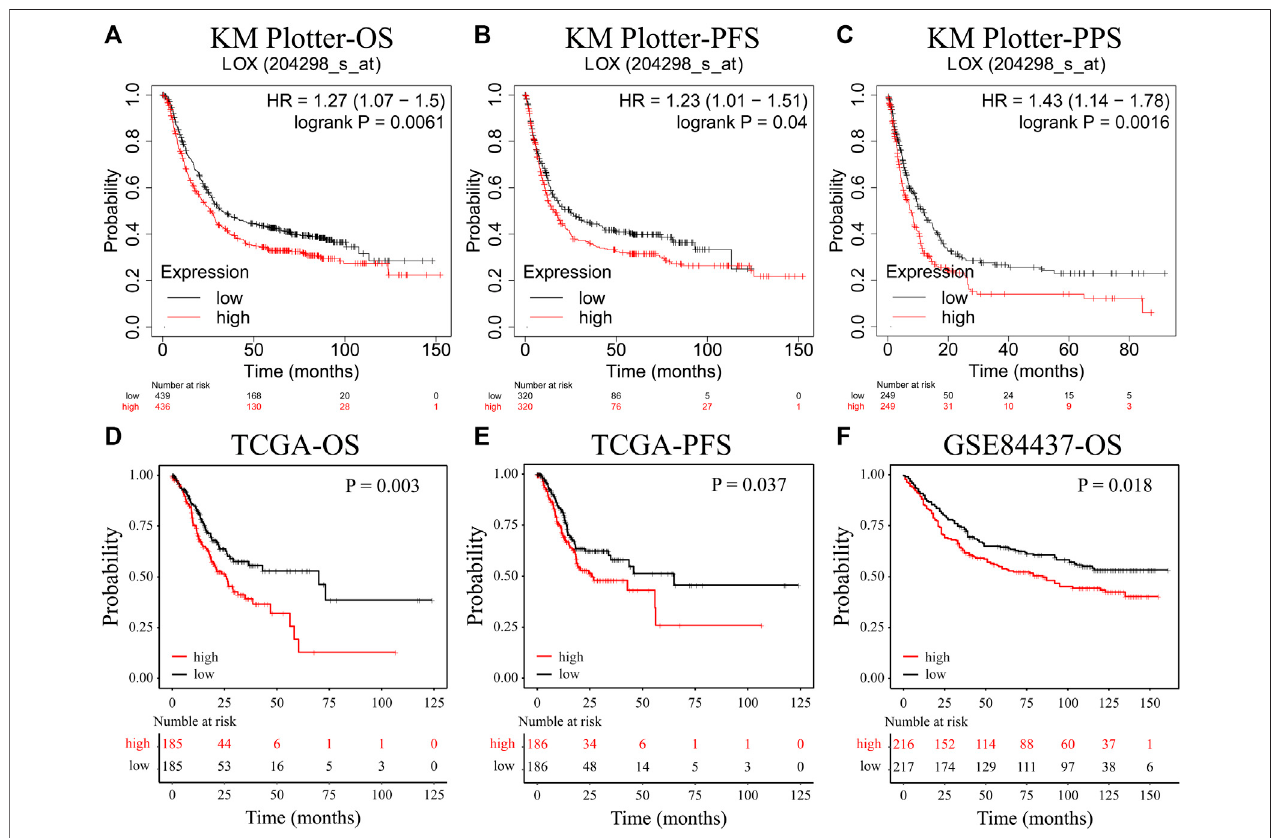
FIGURE 2 | The overexpression of LOX is correlated with poor prognosis of STAD. (A) The overall survival curves of LOX in STAD patients (Kaplan – Meier plotter). (B) Theprogression-freesurvivalcurvesofLOXinSTADpatients(Kaplan – Meierplotter). (C) Thepost-progressionsurvivalcurvesofLOXinSTADpatients(Kaplan – Meier plotter). (D) The overall survivalcurvesofLOXin STADpatients(TCGA). (E) Theprogression-free survivalcurves ofLOX inSTAD patients(TCGA). (F) Theoverall survival curves of LOX in STAD patients (GSE84437).